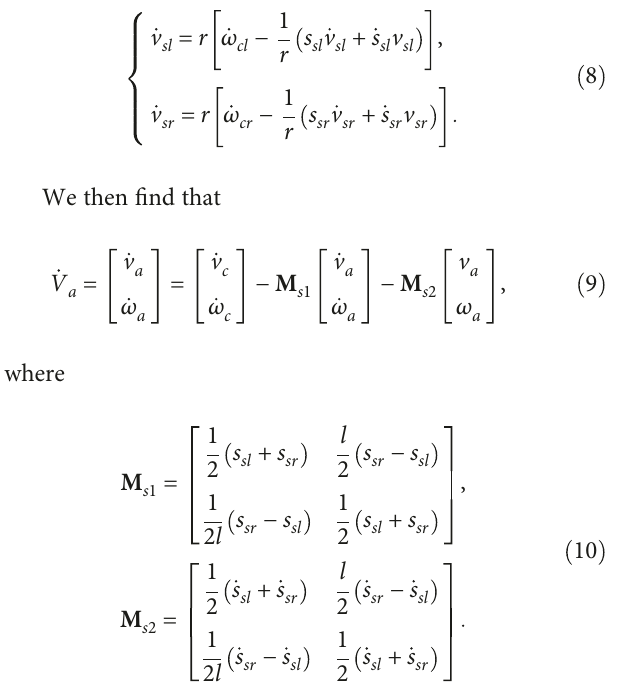
Figure 2: The local coordinate frame attached the robot body and